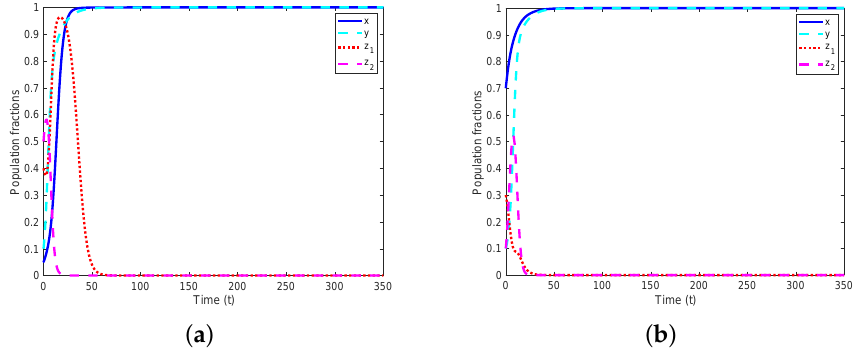
Figure 4. Population evolution of x , y , z 1 , and z 2 over time. ( a ) Evolution of population fractions over time with initial values x ( 0 ) = 0.05, y ( 0 ) = 0.1, z 1 ( 0 ) = 0.4, and z 2 ( 0 ) = 0.5. ( b ) Evolution of population fractions over time with initial values x ( 0 ) = 0.7, y ( 0 ) = 0.1, z 1 ( 0 ) = 0.3, and z 2 ( 0 ) = 0.1.